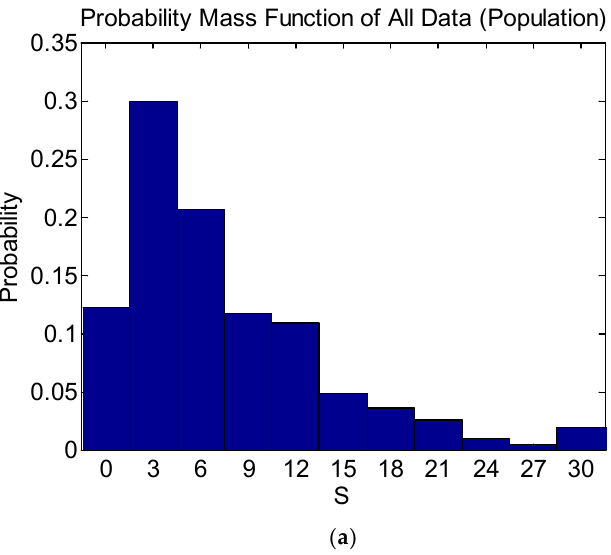
Feed Forward Back Propagation Figure 4. Network topography of ANN.